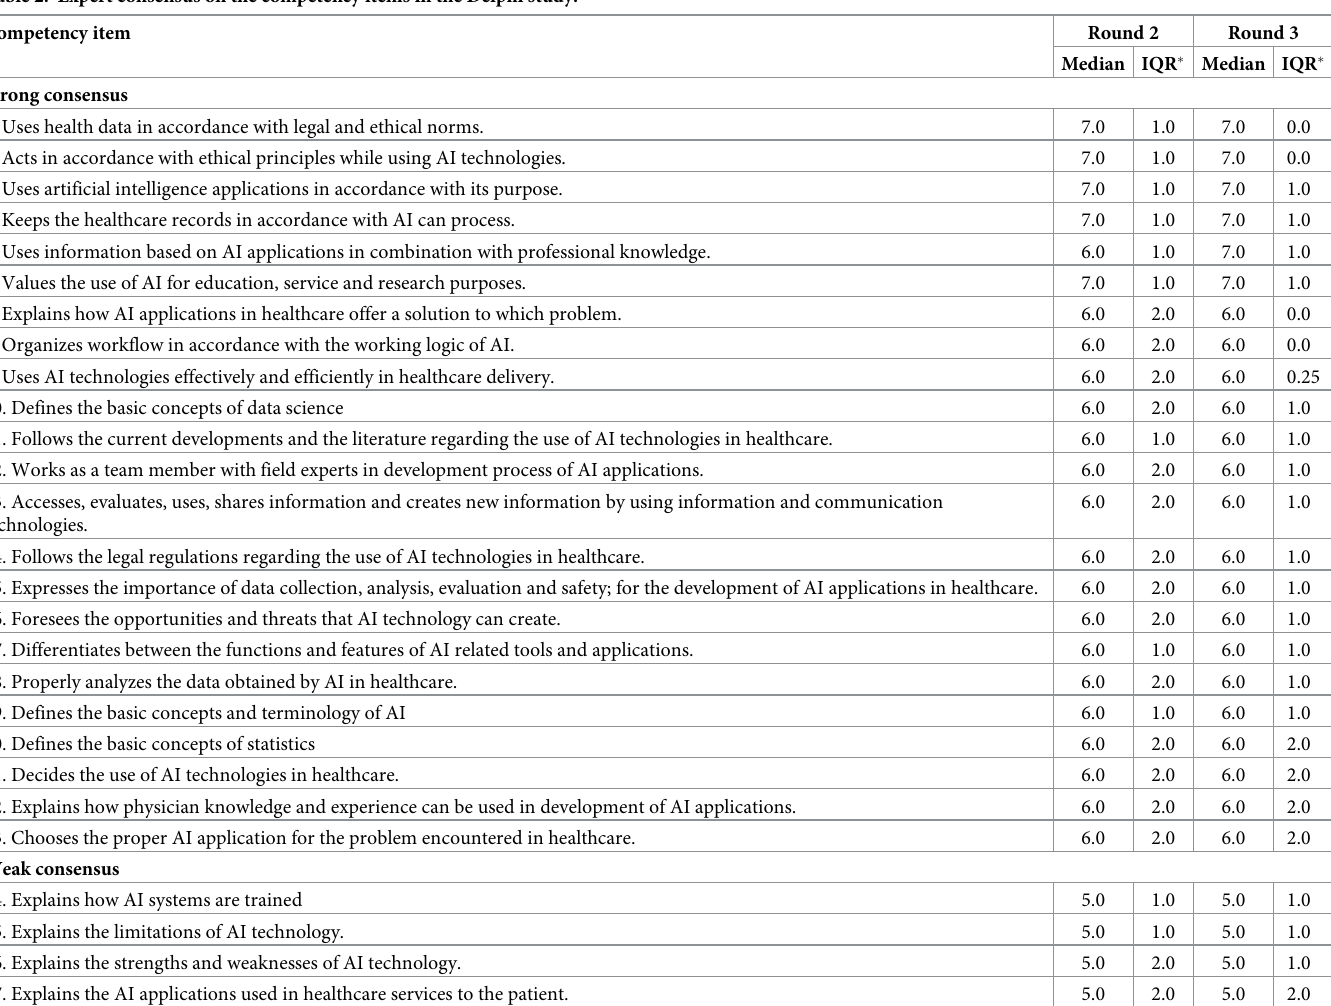
Table 2. Expert consensus on the competency items in the Delphi